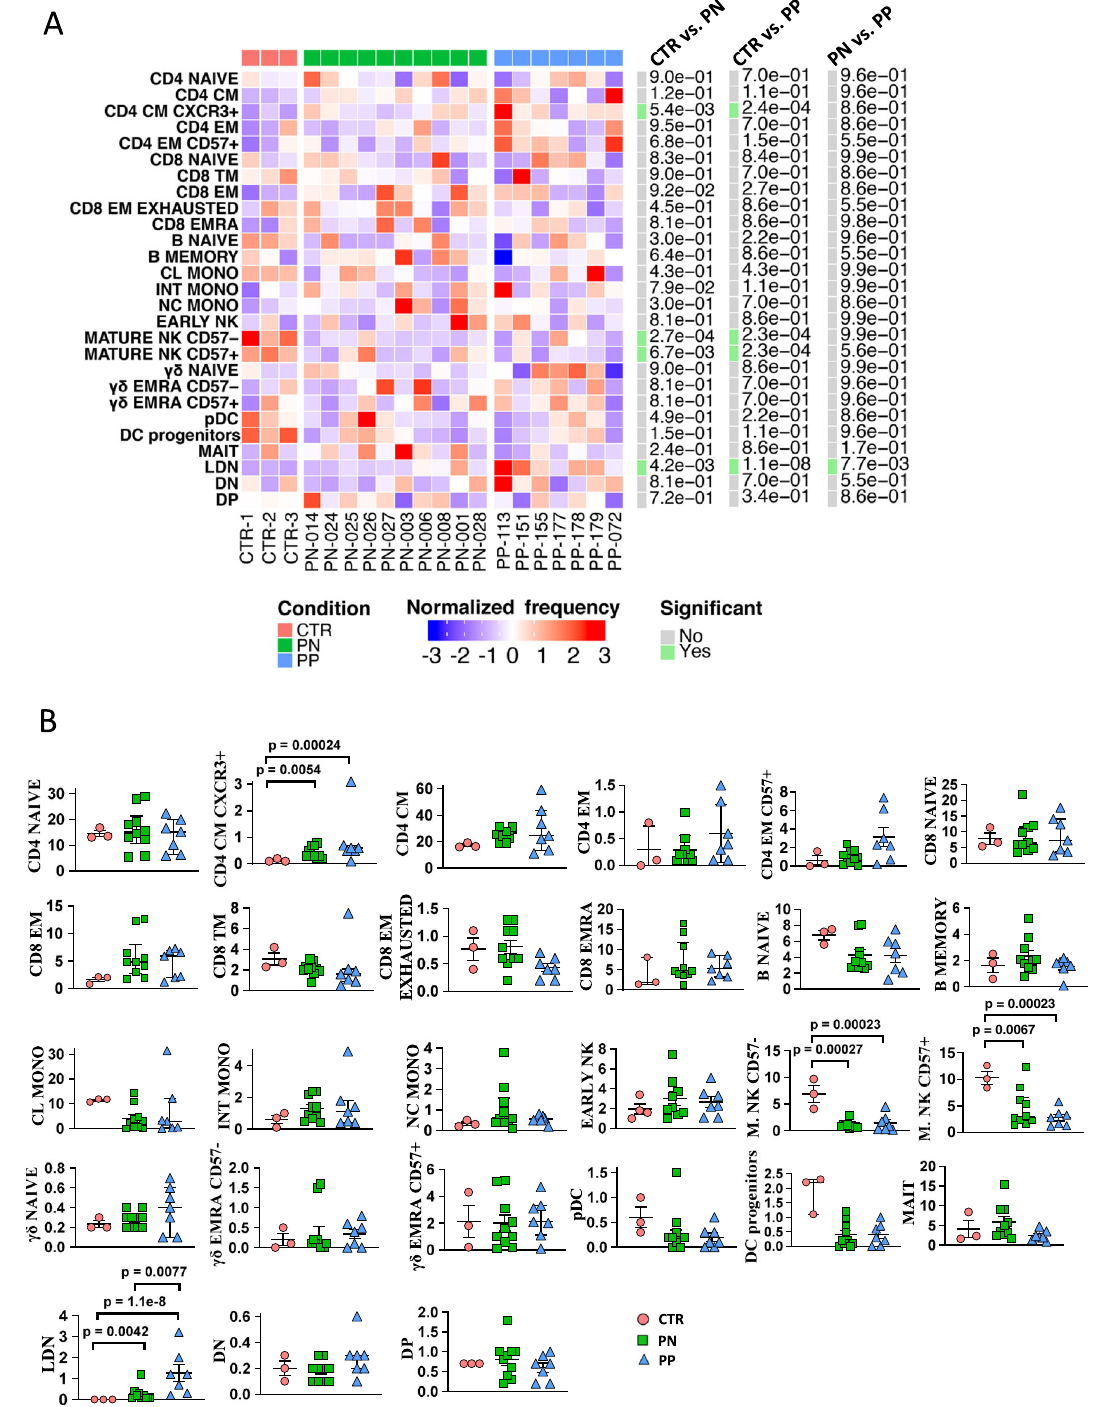
Fig. 2 Detailed statistical analysis of PBMC landscape. A Differential analysis performed using generalized linear mixed model (GLMM) between nonpregnant women (CTR; bar color: salmon; n = 3), uninfected pregnant women (PN; green, n = 10) and infected pregnant women (PP; azure, n = 7). The heat represents arcsine-square-root-transformed cell frequencies that were subsequently normalized per cluster (rows) to mean of zero and standard deviation of one. The color of the heat varies from blue indicating relative underrepresentation to red indicating relative overrepresentation. Bar and numbers at the right indicate signi fi cant differentially abundant clusters (green) and Bonferroni-adjusted p-values obtained from GLMM statistical test. B Analysis of the different cell populations identi fi ed as in panel A . A signi fi cant difference was observed in the percentage of low-density neutrophils (LDN), in infected pregnant women (PP) vs. uninfected pregnant (PN) or vs. healthy donors (CTR). The dot plots show the relative abundancies of 27 populations found within precleaned CD45 + live cells. Values (dots) for the three conditions are matched with the color used in A . Data represent individual percentage values (dots), median (center bar), and SEM (upper and lower bars). Generalized linear mixed model (GLMM) with Bonferroni correction has been used. The exact p -value is indicated in the fi gure. Source data are provided as a Source Data fi